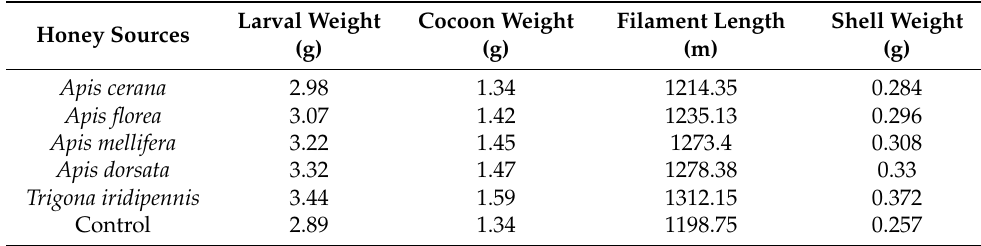
Table 3. The impact of honey produced by different honey bees on the economic parameters of Bombyx mori [20].